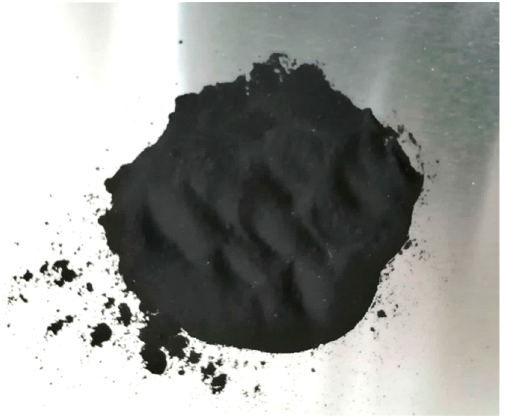
Figure 4. Biocoal from step c of case 3 (biocoal 3c ).